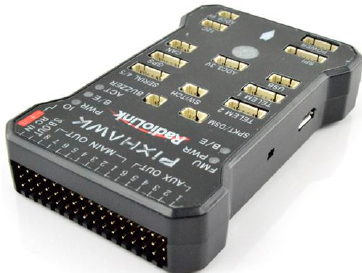
Figure 5. Pixhawk controller for fixed-wing UAV.